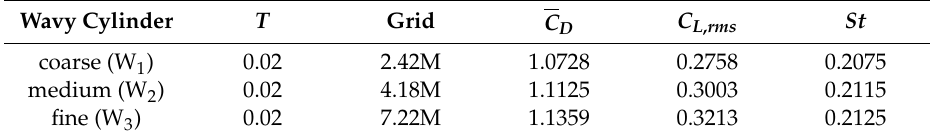
Table 3. Grid independence verification on wavy cylinder.